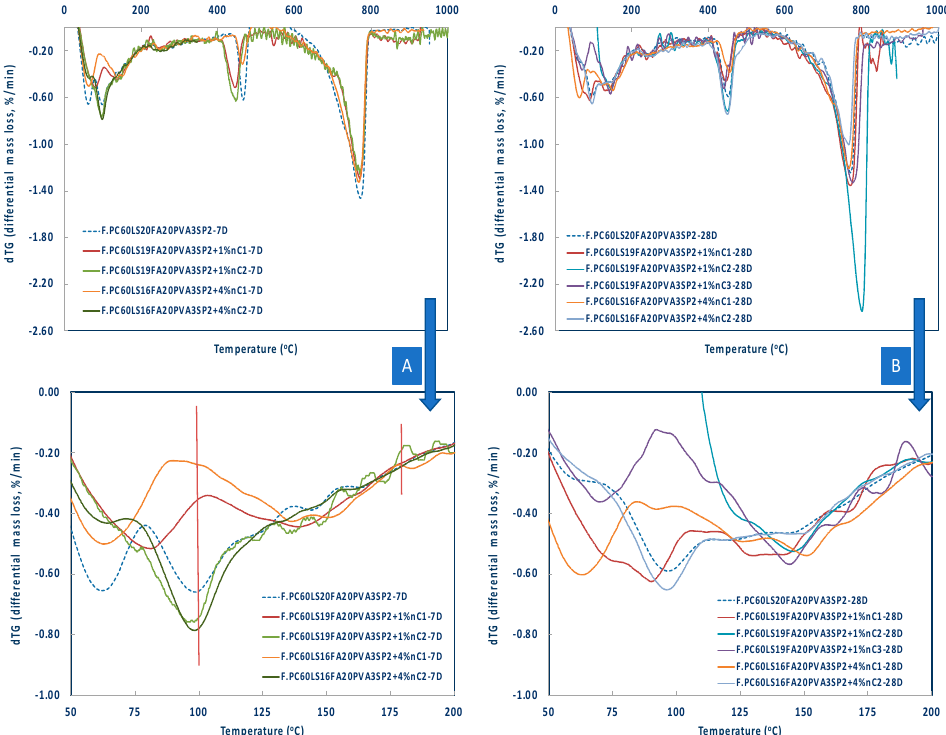
Figure 9: Differential mass loss between 100–200 °C of nMt and fibre reinforced cementitious nanocomposites at ( A ) Day 7 and ( B ) Day 28.